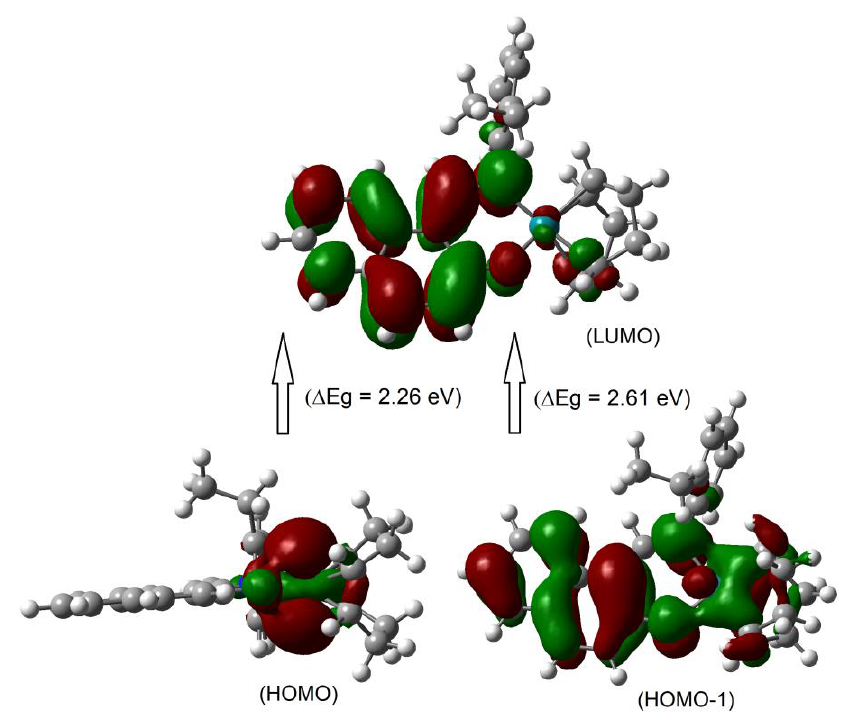
Figure 4. The frontier HOMO-1, HOMO and LUMO orbitals for compound 2 calculated at B3LYP/SDD with PCM in chloroform.